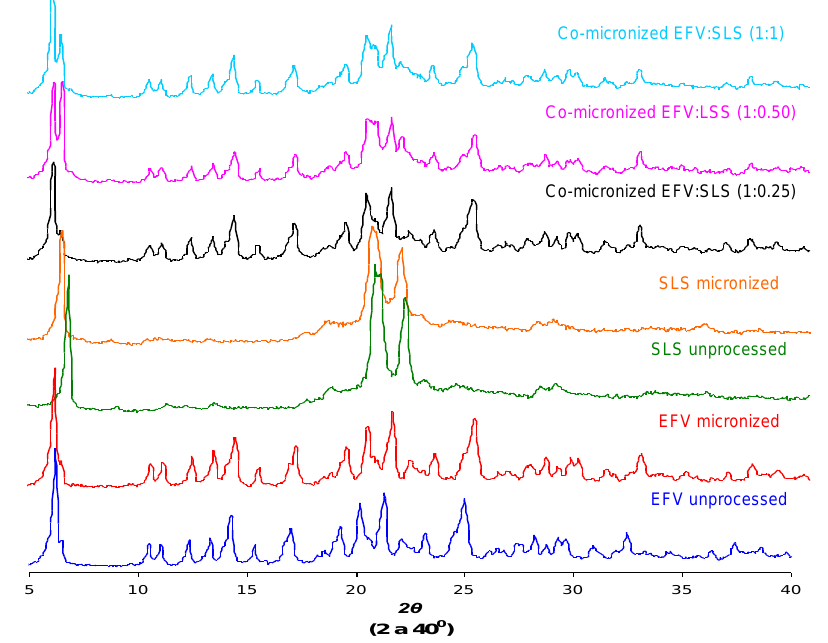
Figure 12. X-ray diffraction patterns of unprocessed and micronized EFV and SLS, compared to co-micronized EFV:SLS mixtures at the proportions (1:0.25), (1:0.50) and (1:1).